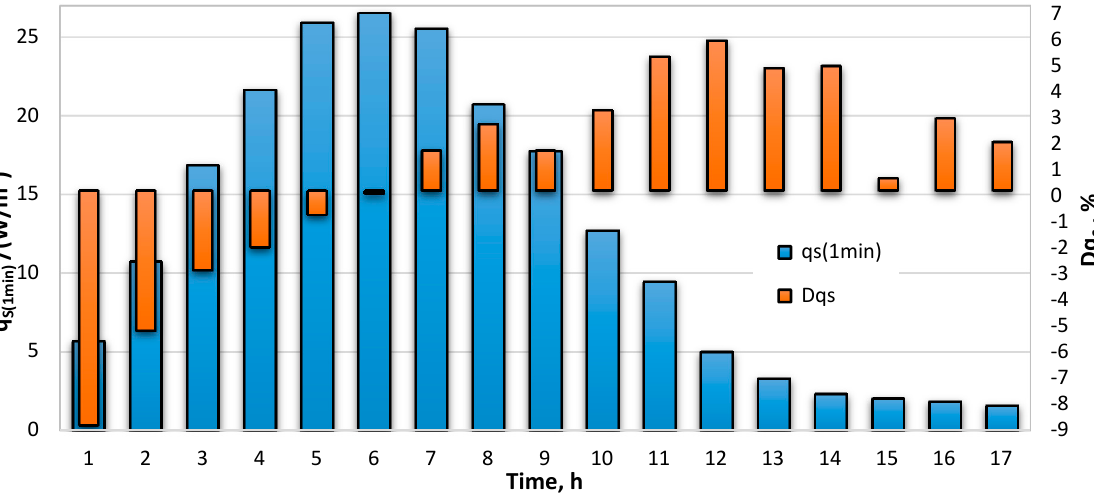
Figure 18. Heat loss calculated with a 1 min step and error resulting from the use of a 1 h time step— P 4 measurement series.